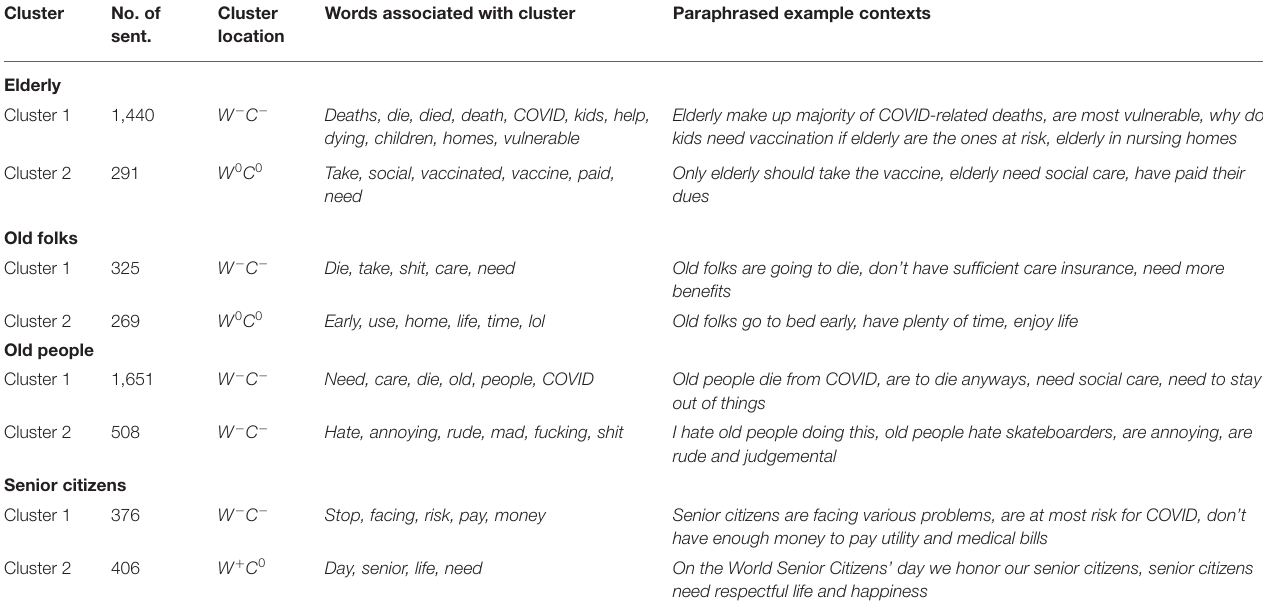
TABLE 8 | Words associated with different clusters and paraphrased example contexts where the words appear for each age-related target group. Cluster No. of